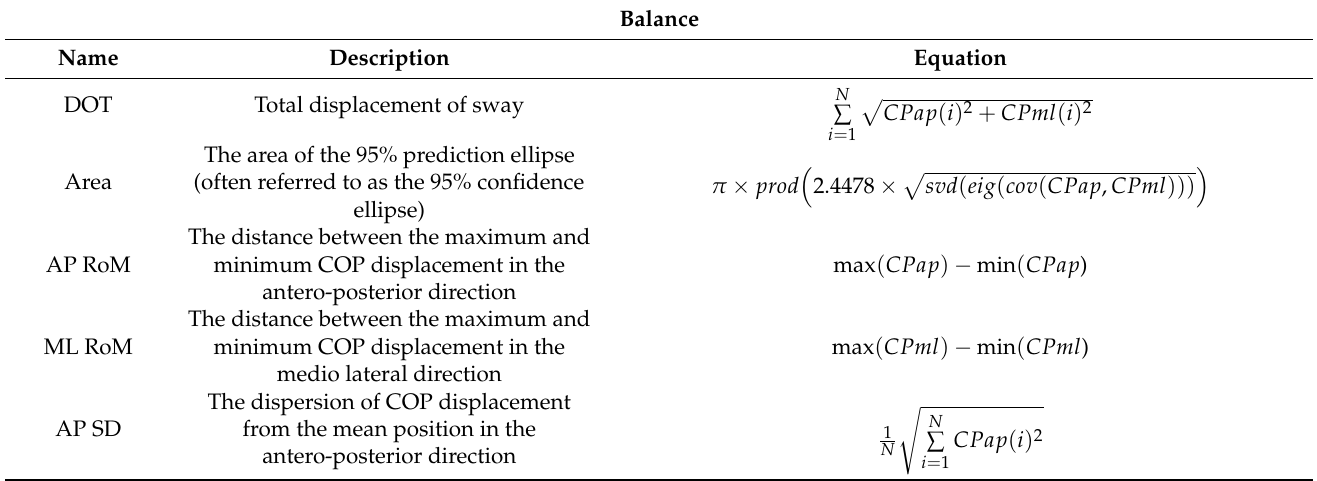
Table 1. Descriptions of the variables used in this study and equations used to process the